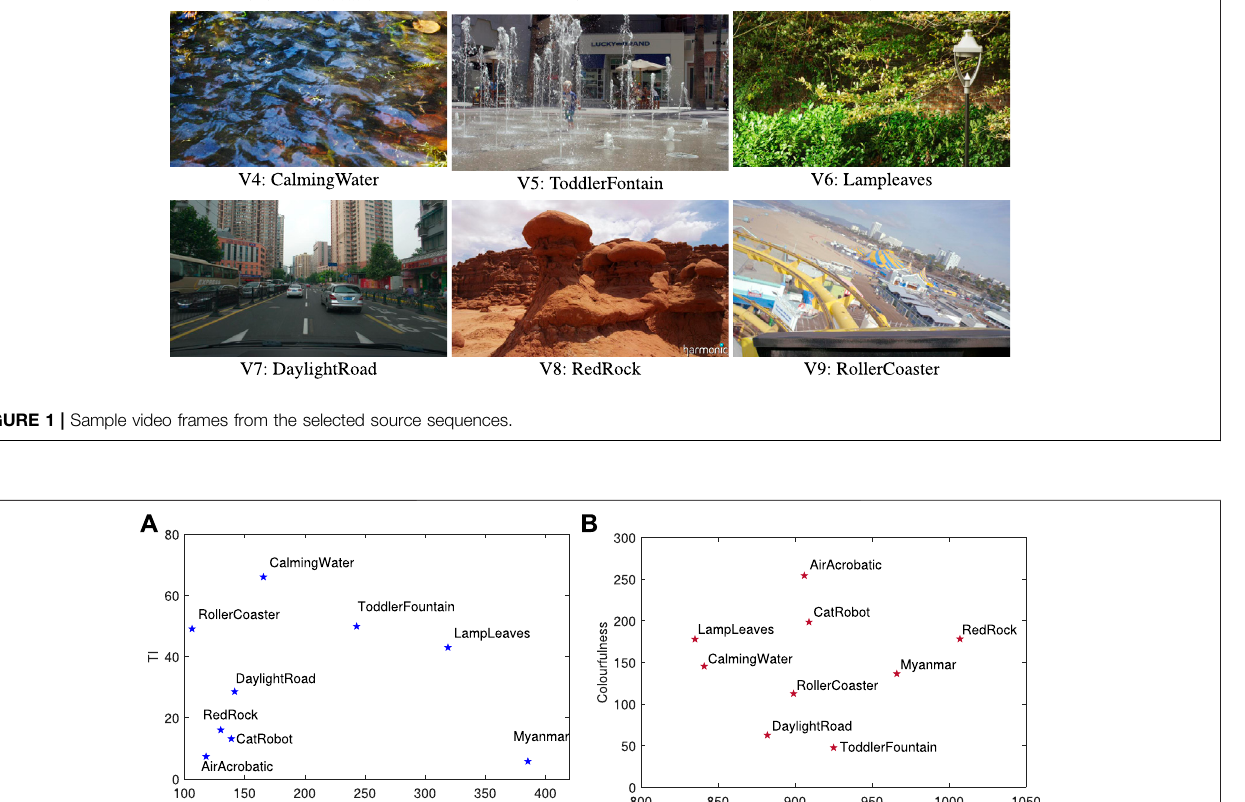
Frontiers in Signal Processing |